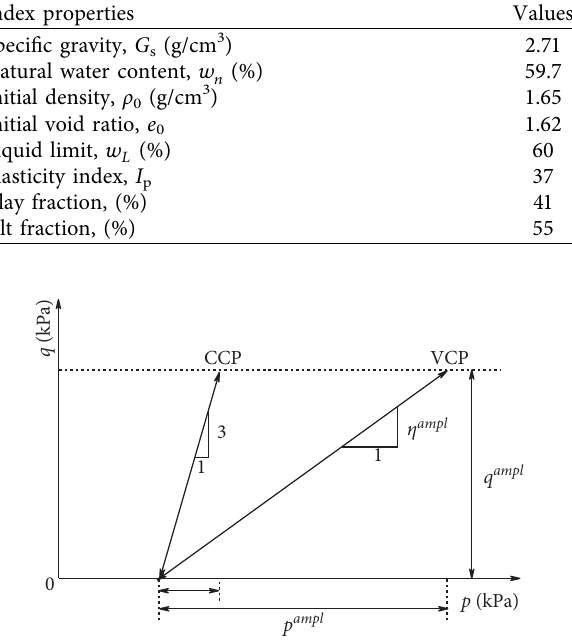
Figure 2: Stress paths of the tests in p-q space. Table 2: Scheme of CCP and VCP